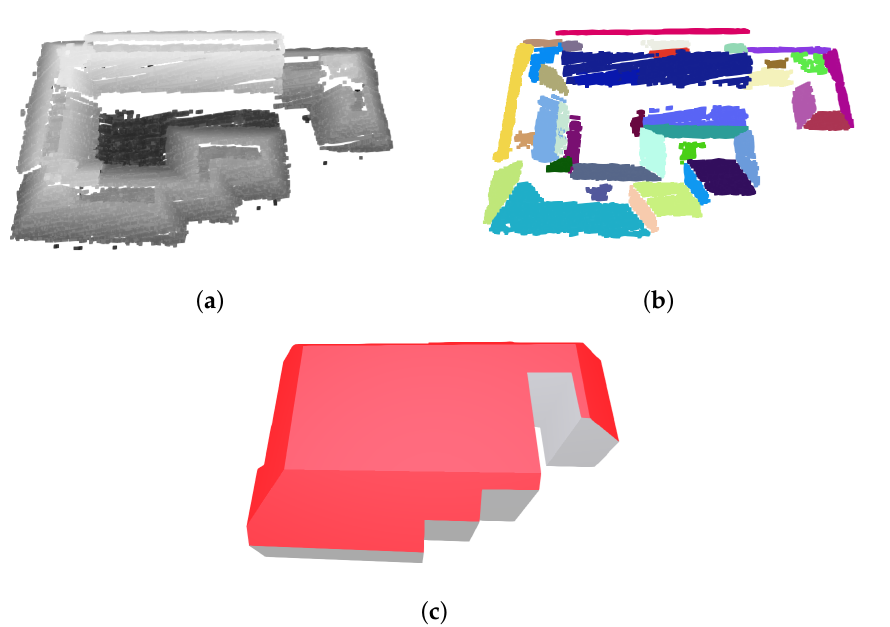
Figure 8. Illustration of shaping a large building with height jumps and too many obstructed half-spaces where from ( a ) the input point cloud segments of points ( b ) were obtained and only unobstructed half-spaces were considered for the reconstruction of the building ( c